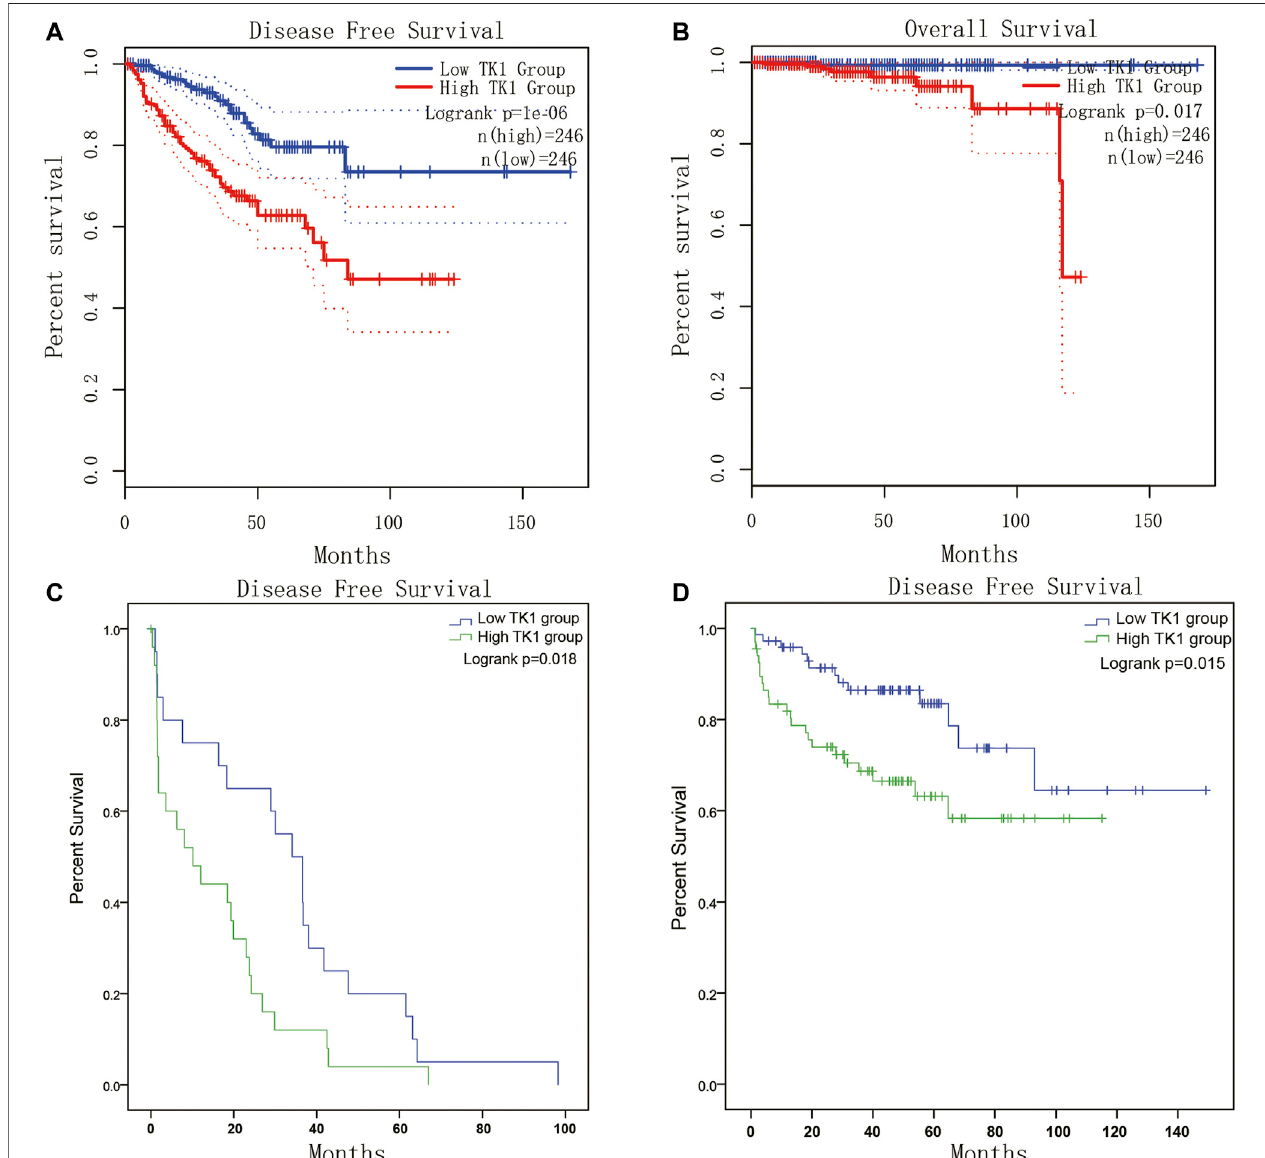
FIGURE5| SurvivalanalysisofTK1expressioninPCa. (A,B) TheTK1mRNAexpressionlevelrepresentedaprognosticvalueinOS (A) andinDFS (B) inthePRAD dataset. (C,D) Kaplan-Meier plots of the risk of biochemical recurrence in PCa patients with high or low expression of TK1 in several cohorts of human prostate tumors.